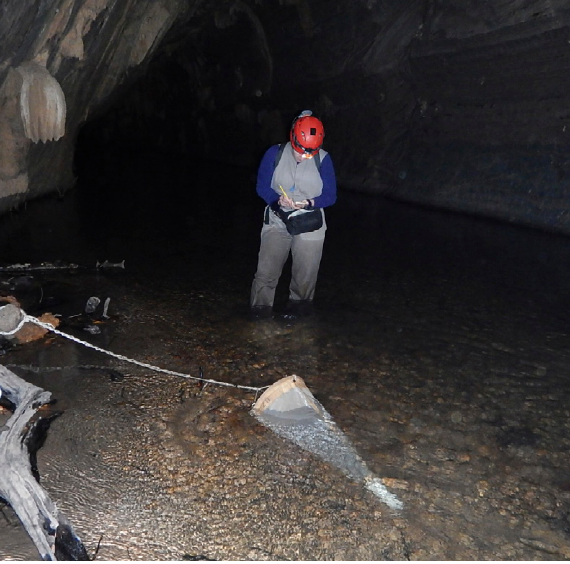
Figure 5. Duto do Quebó, Nobres, Mato Grosso state, Brazil. Photo by J.S. Gallo.